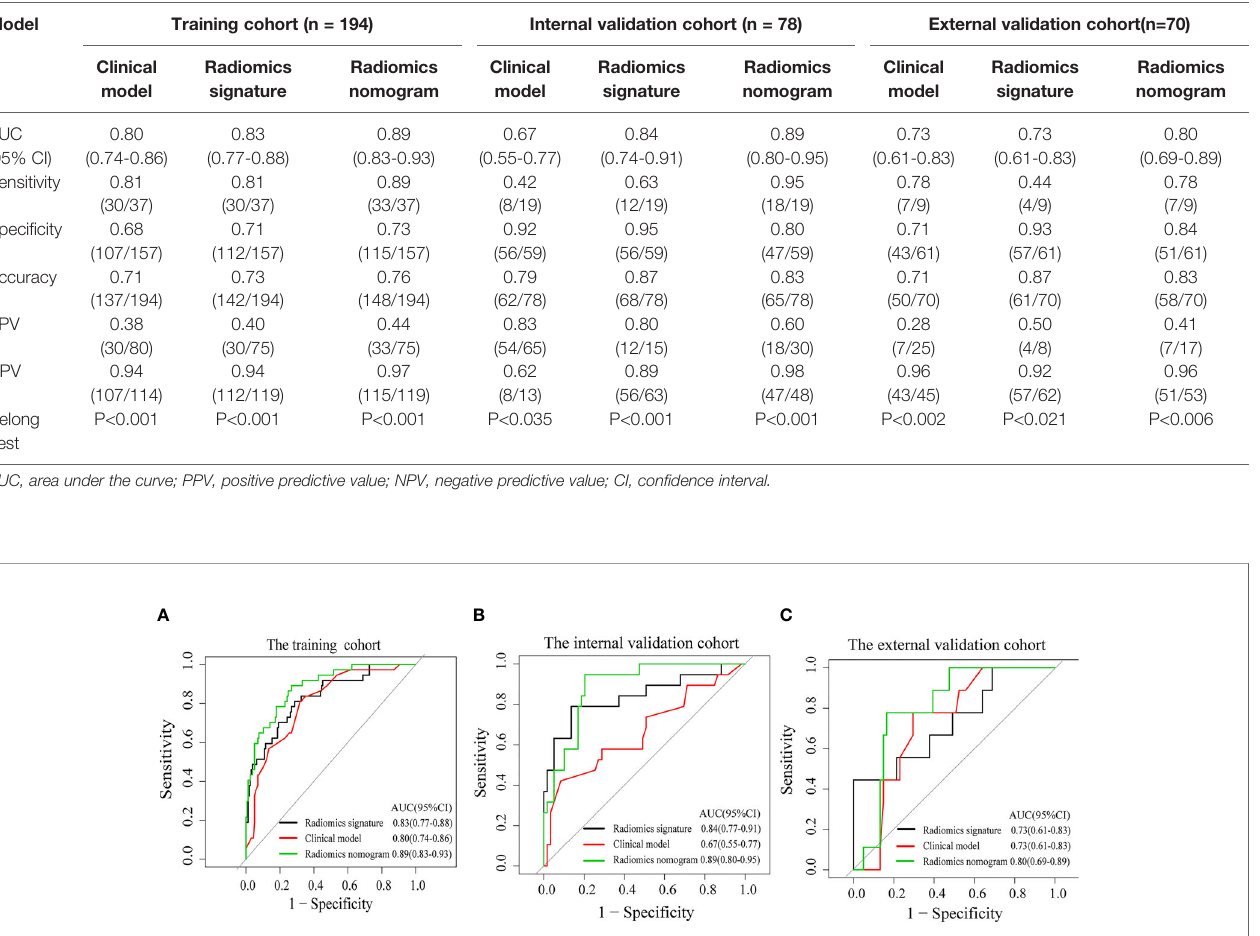
FIGURE 4 | Receiver operating characteristic curves of the clinical model (red line), the radiomics signature (black line), and the radiomics nomogram (green line) in the training cohort (A) and the validation cohorts (B, C)